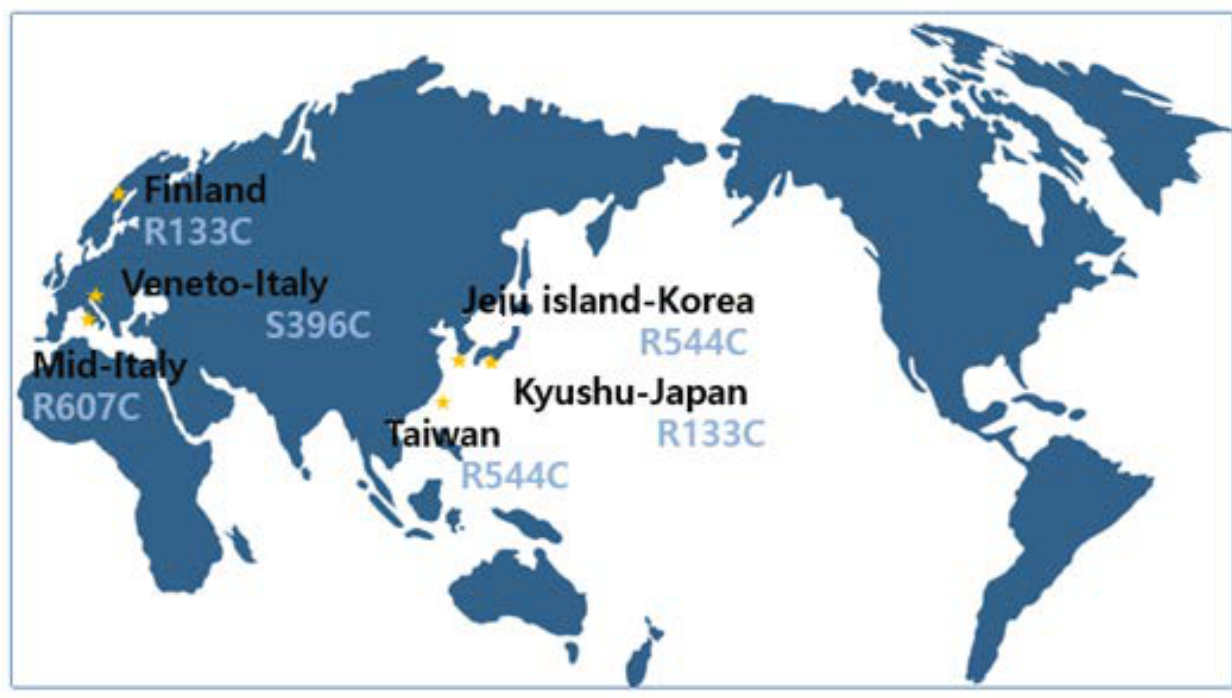
Figure 3. “Founder effect” reported in many countries: Taiwan (R544C) [29], Jeju island in Korea (R544C) [17,18], Finland (R133C) [37], the Kyushu area in Japan (R133C) [19], mid-Italy (R607C) [35] and the Veneto region in Italy (S396C) [38]. * This figure was modified from